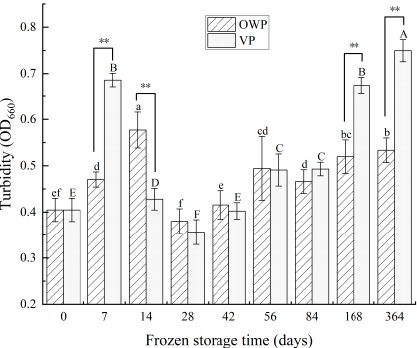
Figure 5. Changes in turbidity of yak rumen SMP during frozen storage. Different superscript letters in the figure indicate significant difference in storage time ( p < 0.05), lowercase letters are for OWP and uppercase letters for VP. “**” indicates that the difference packaging is extremely significant ( p < 0.01).